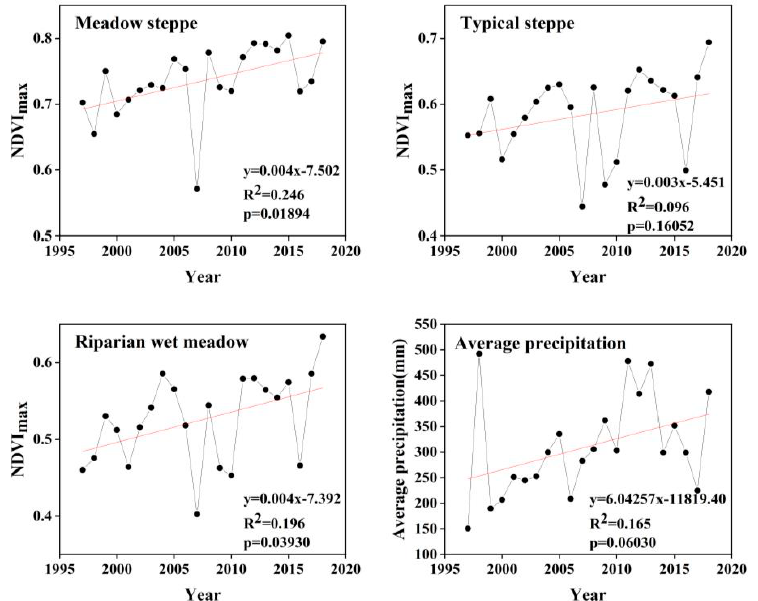
Figure 6. NDVI max and precipitation trends for the three ecosystem types from 1997 to 2018.